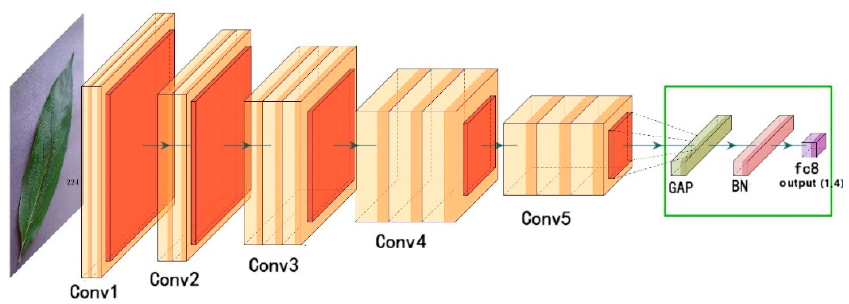
Figure 3. A schematic of the proposed CNN based on VGG16.